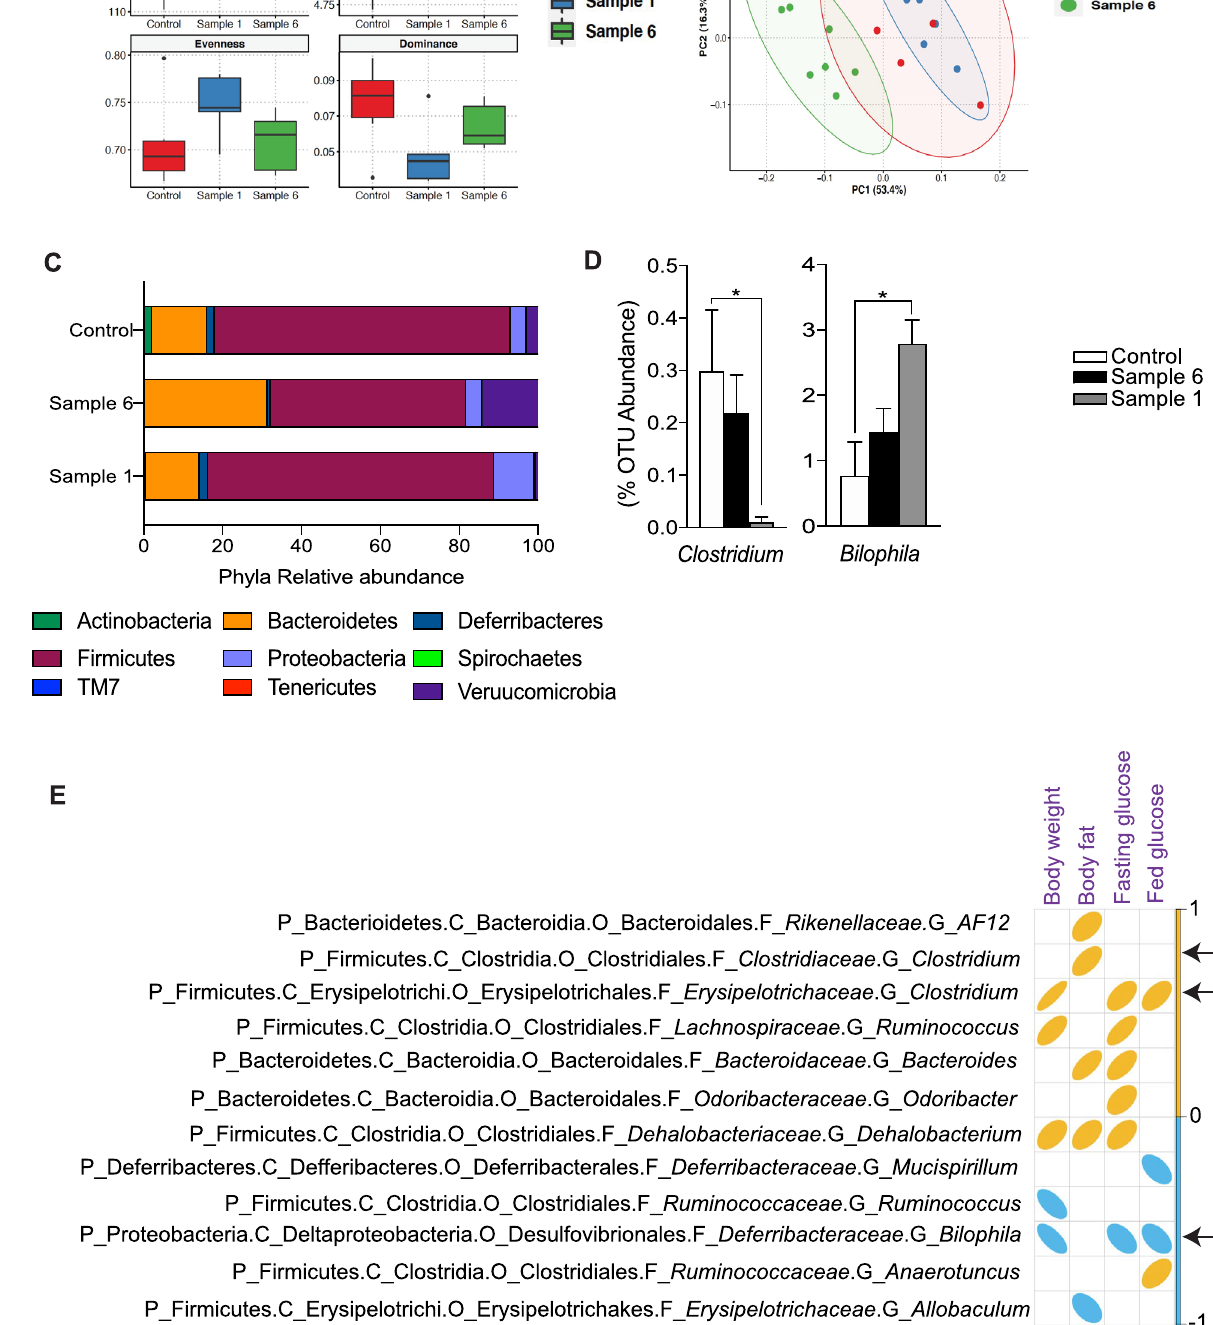
Figure 6. Cordyceps enriched in myriocin modulates gut microbial composition. C57Bl6/J mice fed high fat diets supplemented with starch (control), Sample 1 and Sample 6 for 12-weeks. Following euthanasia, cecum contents were collected and the composition of gut microbes was determined by 16S rRNA amplicon sequencing ( A ) Indices of α-diversity (Observed OTUs, Shannon Diversity, Evenness and Dominance). ( B ) β-diversity based principal component analysis (PCA) plot. ( C ) Relative abundance of gut microbes at phyla level. ( D ) Relative abundance of genera such as Clostridium and Bilophila. ( E ) Spearman’s correlation of selected gut microbes at genus level with body weight, body fat, fasting blood glucose or fed blood glucose (N = 5–7 animals per group). Values are expressed as mean ± SEM, *p < 0.05, **p < 0.001, ***p < 0.0001 vs